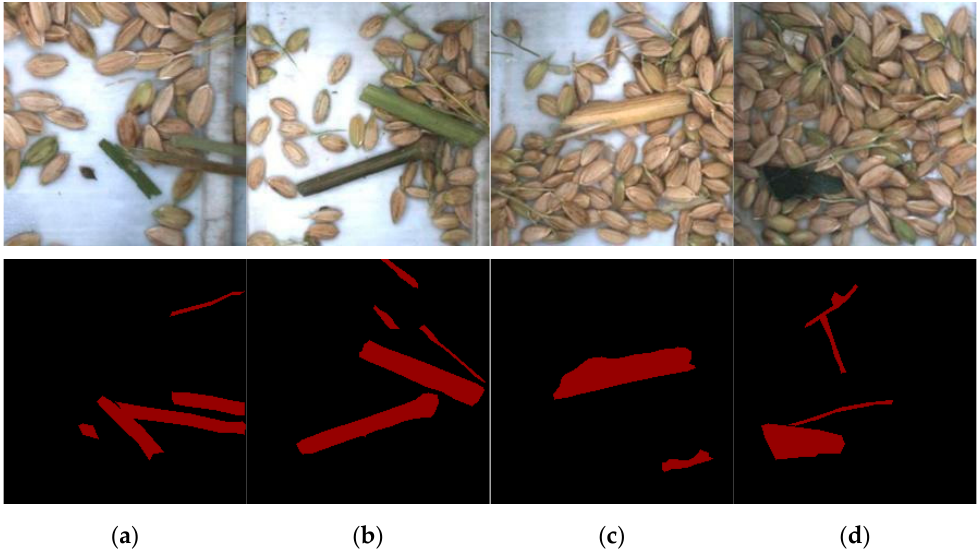
Figure 6. The captured grain image and the impurity mask image. ( a ) Fine impurities; ( b ) coarse impurities; ( c ) impurities approximating the color of rice; ( d ) irregular shape impurities.